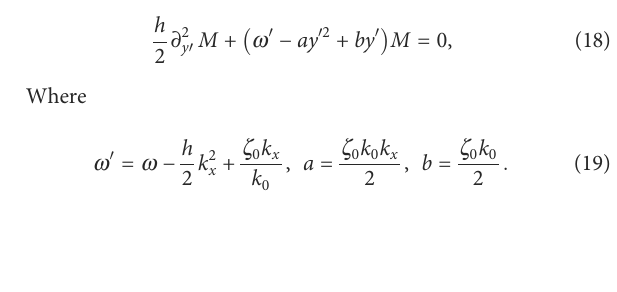
ffiffiffi p hk 2 = z : 2,1,5, respectively. Shaded areas indicate 2 0 = 0 0